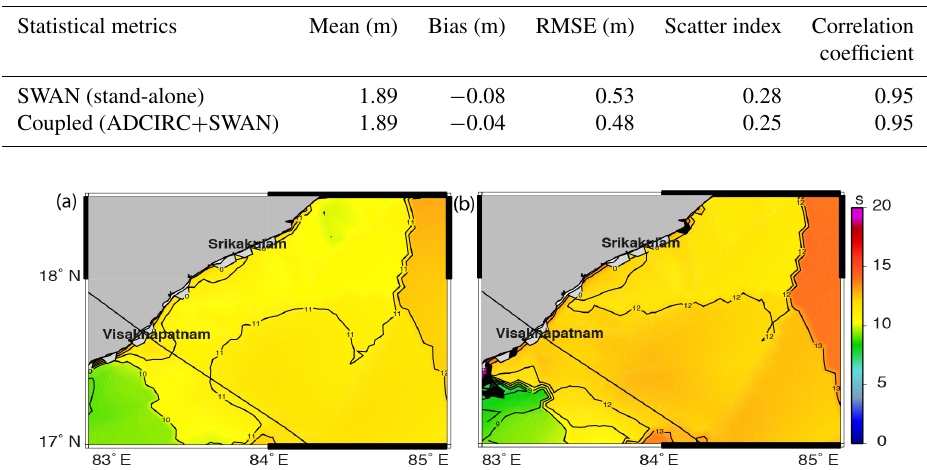
Figure 11. Spatial distribution of (a) mean wave period ( T m ) and (b) peak wave period ( T p ) simulated along the track of the Hudhud cyclone using coupled ADCIRC + SWAN model (with wave–current interaction).